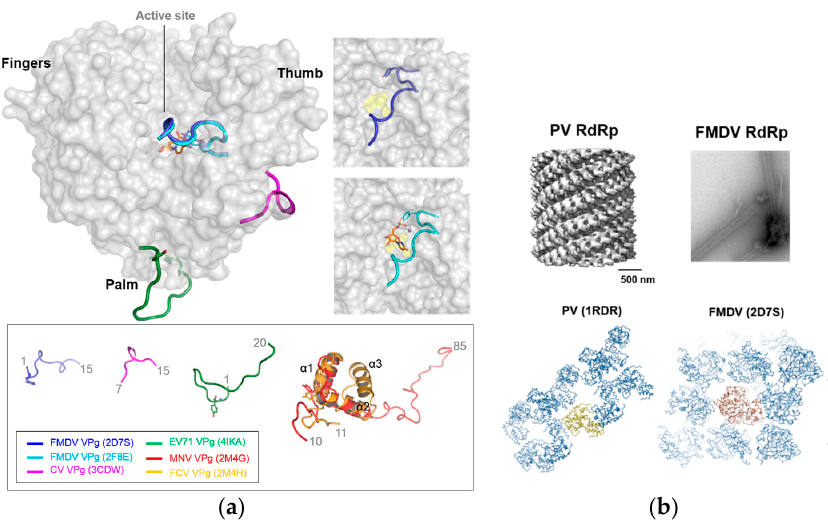
Figure 5. Structures of the RdRp-VPg complexes. ( a ) Superposition of the RdRp–VPg complex structures from foot and mouth disease virus (FMDV), coxsackievirus (CV), and enterovirus 71 (EV71) in picornaviruses. FMDV VPg is bound at the active site, while CV VPg is at the junction of the palm and thumb and EV71 VPg is bound at the bottom of the palm. In the box below, caliciviral and picornaviral VPg structures are shown; ( b ) Multimerization of the PV and FMDV RdRps. Cryo-electronmicroscopy (EM) reconstructed or negative-stained transmission electron microscopy (TEM) images of RdRps (upper panel) and the interactions of RdRp molecules in the crystal lattices (lower panel). PV and FMDV RdRp fibril images are adopted from Electron Microscopy Data Bank (EMDB) and [43], respectively.